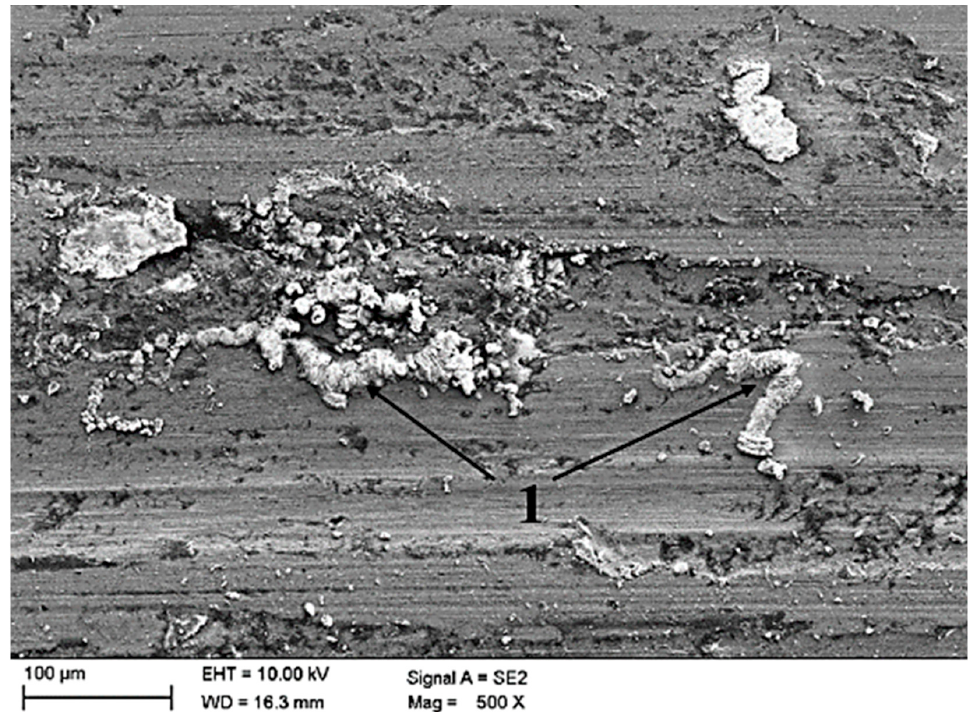
Figure 10. EDS spectrum of Point 1 according to Figure 9a ( a ); EDS spectrum of Point 1 according to Figure 9b ( b ).